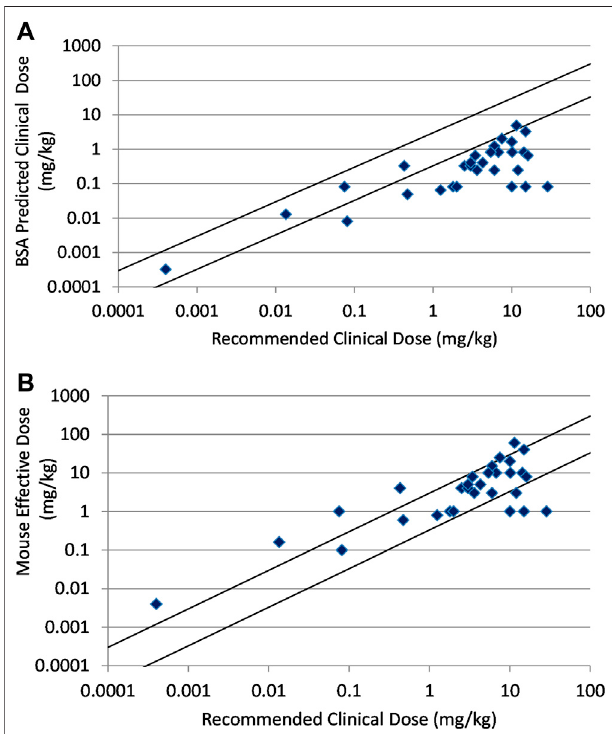
FIGURE 2 | (A) Relationship between recommended clinical doses and clinical doses predicted from BSA scaling of mouse effective doses for thirty marketed, large molecule oncology drugs. (B) Relationship between recommended clinical doses and mouse effective doses for thirty marketed, large molecule oncology drugs. Solid lines indicate plus and minus 3-fold from precise prediction.